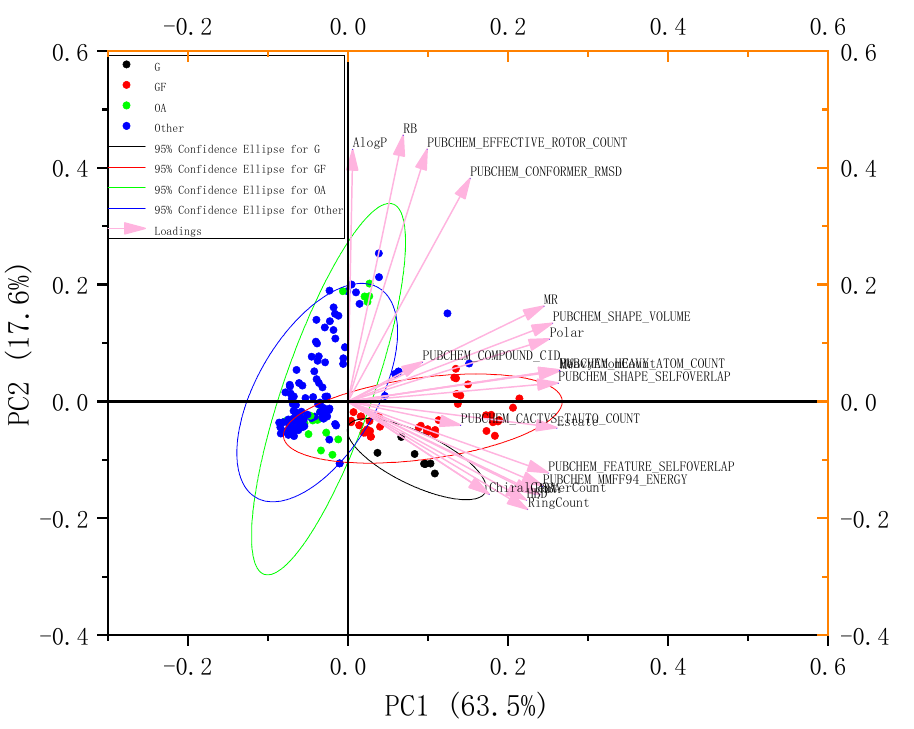
Figure 3. Principal component analysis of the physical and chemical properties of the 193 small molecules belonging to EGb.